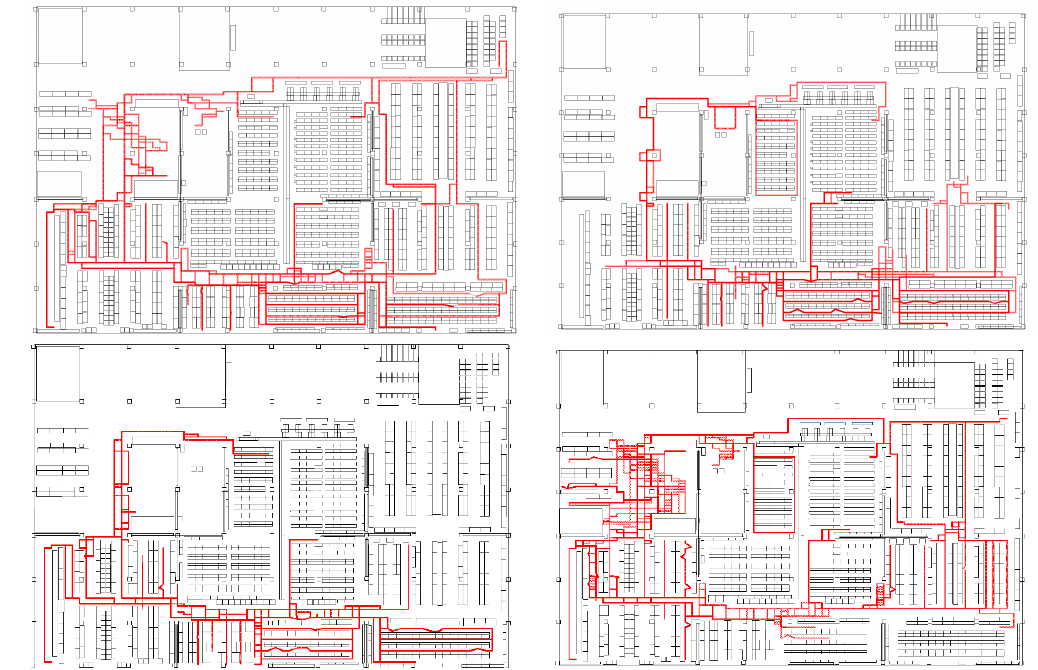
Figure 15. Examples of trajectories in the VDR track ( Top Left : 3/15 Dev#57, Top Right : 3/19 Dev#57, Bottom Left : 3/14 Dev#13, Bottom Right : 3/19 Dev #5).